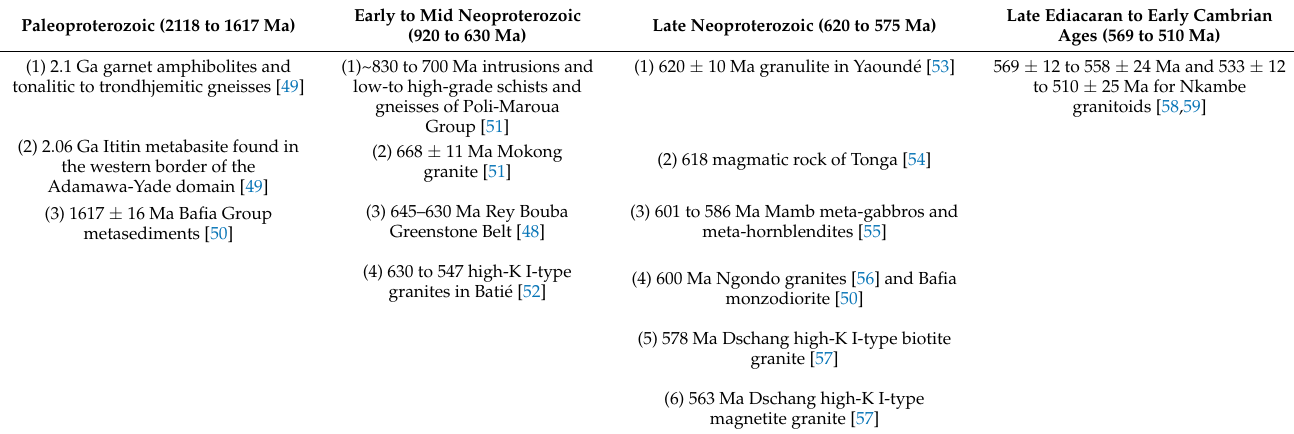
Table 1. Ages of some Paleoproterozoic to Early Cambrian rocks found within the Cameroon mobile belt. Paleoproterozoic (2118 to 1617